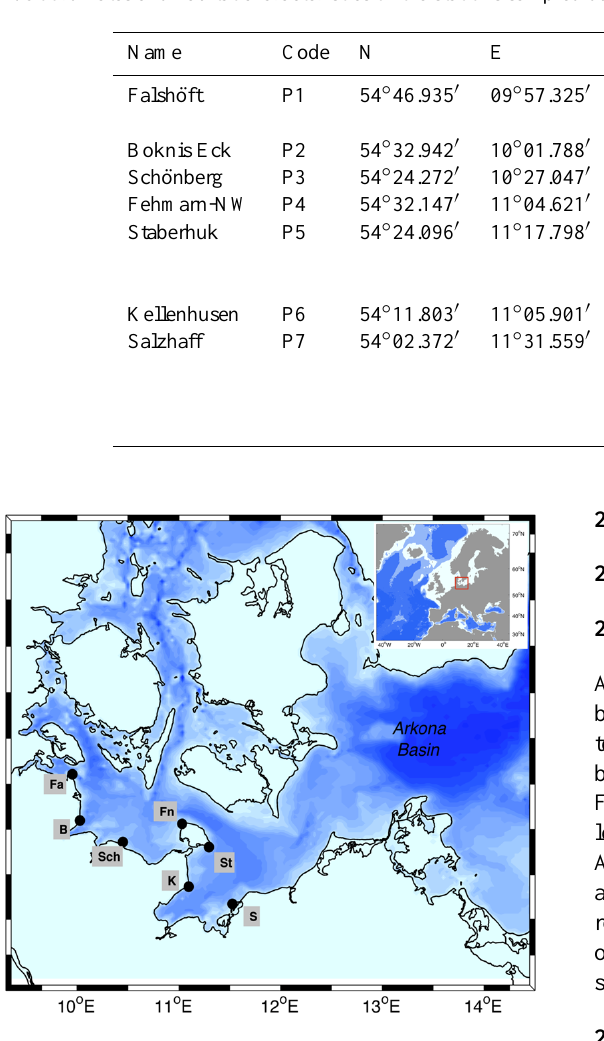
Fig. 1. Chart depicting the position of the seven stations in Kiel and L¨ubeck Bight sampled in this